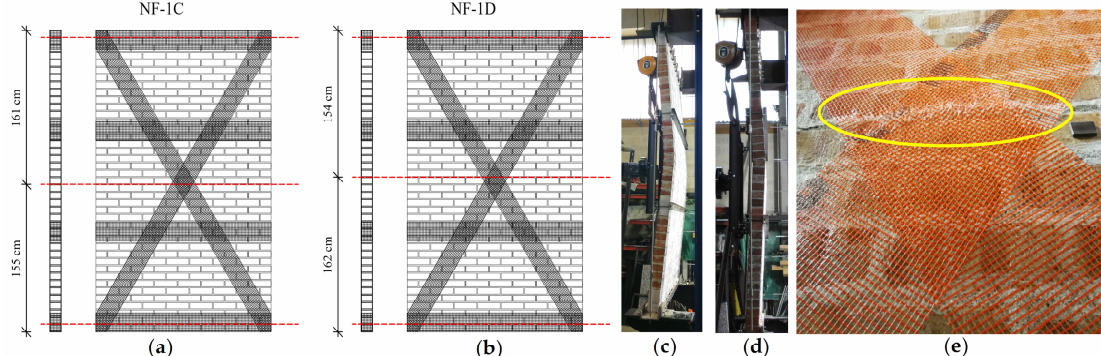
Figure 7. Crack development locations (red dashed lines) of specimens with diagonal and horizontal strips strengthening systems ( a ) NF-1C and ( b ) NF-1D; deformation shape of specimens ( c ) NF-1C and ( d ) NF-1D; ( e ) tension failure of RM diagonal strips at intersection in